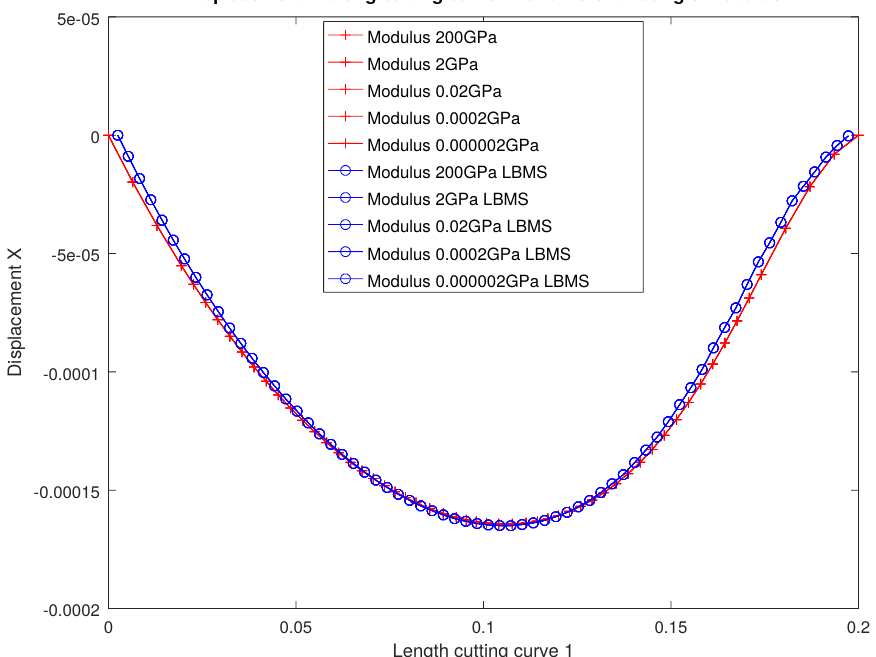
Figure A15. First displacement components along cutting curve C 1 for different Young’s modulus.